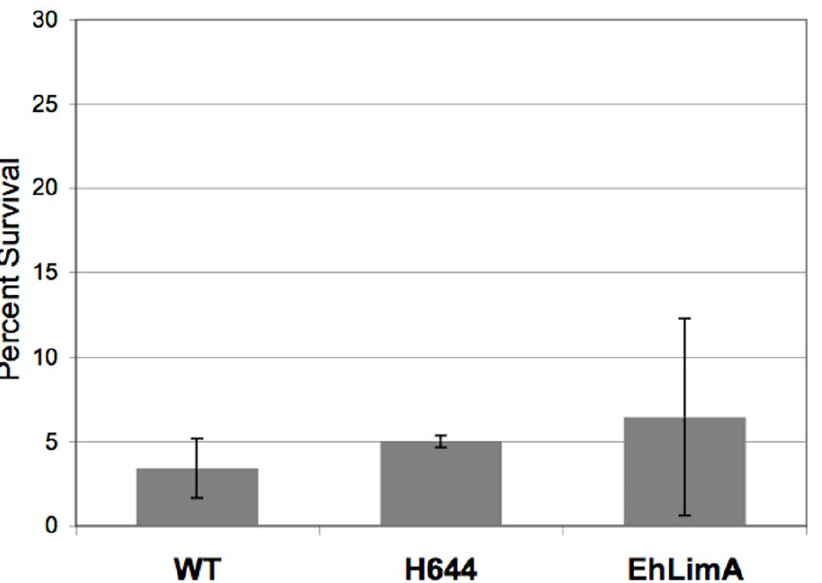
Figure 7. Phagocytosis is reduced in E.histolytica cells over-expressing H644 or EhLimA. Wild-type (WT) or transgenic cells were incubated with erythrocytes (hRBC:amoeba ratio; 100:1) for 10 minutes, lysed, and spectrophotometrically analyzed for internalized heme at 405 nm. The data represent the mean 6 S.D. of 4 experiments (** P , 0.01; * P , 0.05). Amoebae over-expressing H644 or EhLimA exhibit reduced phagocytosis of hRBCs.